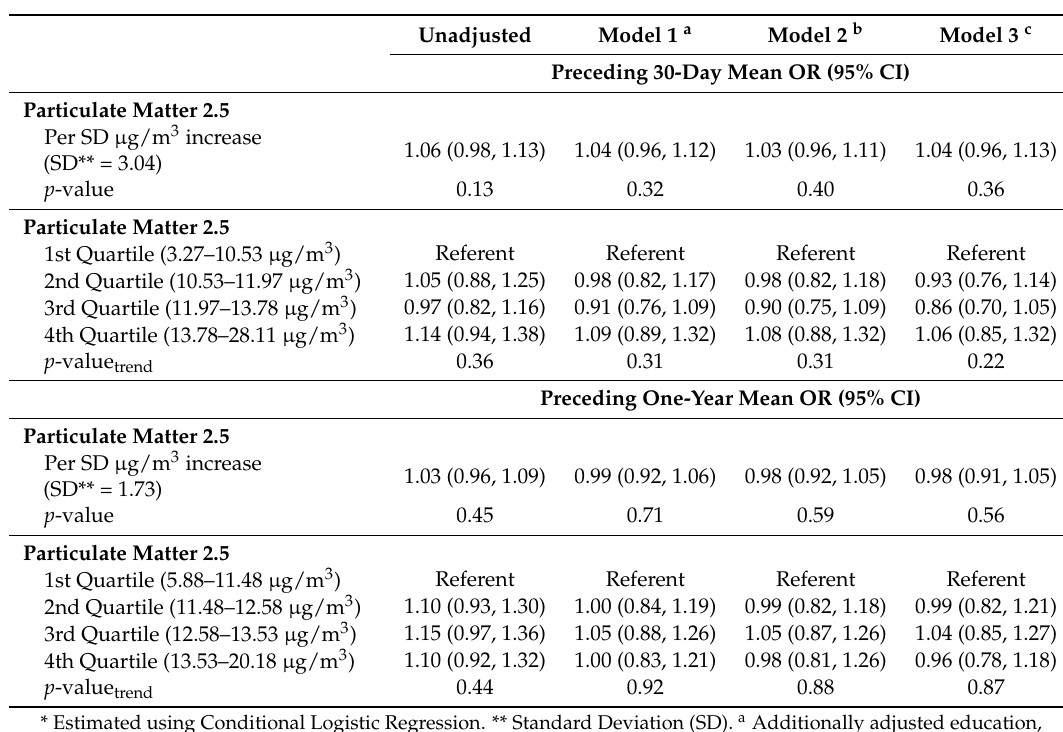
Figure 2. Distribution of average daily mean particulate values for 30-day preceding sepsis case event among 6906 cases and controls. Table 2. Odds ratios * (ORs) and associated 95% confidence intervals (CIs) for the association between the preceding 30-day and one-year mean particulate matter 2.5 and incident sepsis. Among 1386 sepsis cases and 5544 controls matched on age ( ± 5 years), race, and